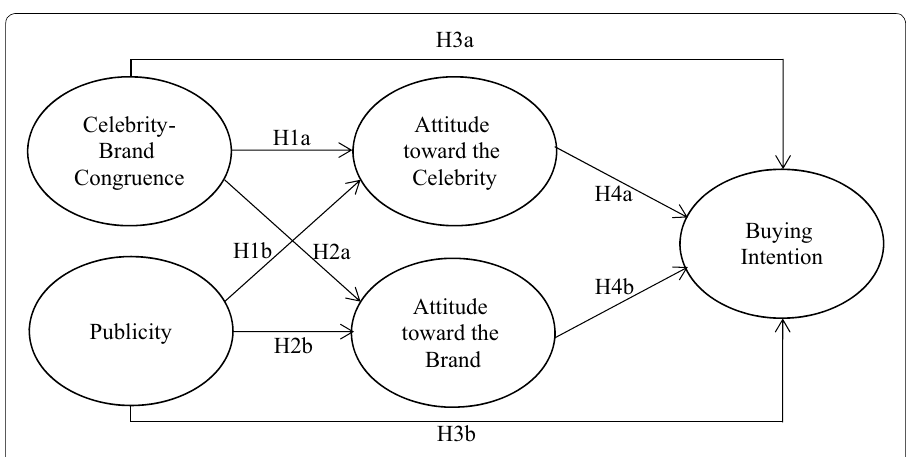
Fig. 2 Theoretical framework for this